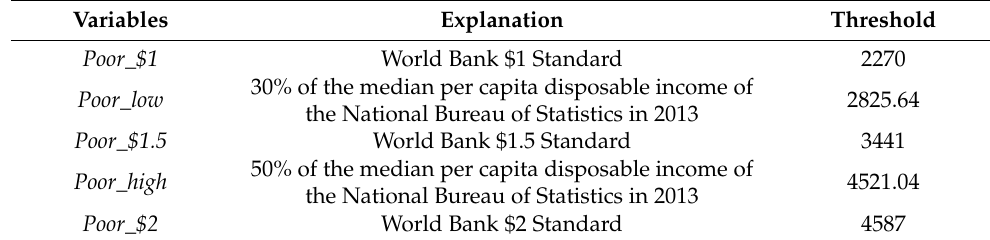
Table 1. Explanation and description of related variables.